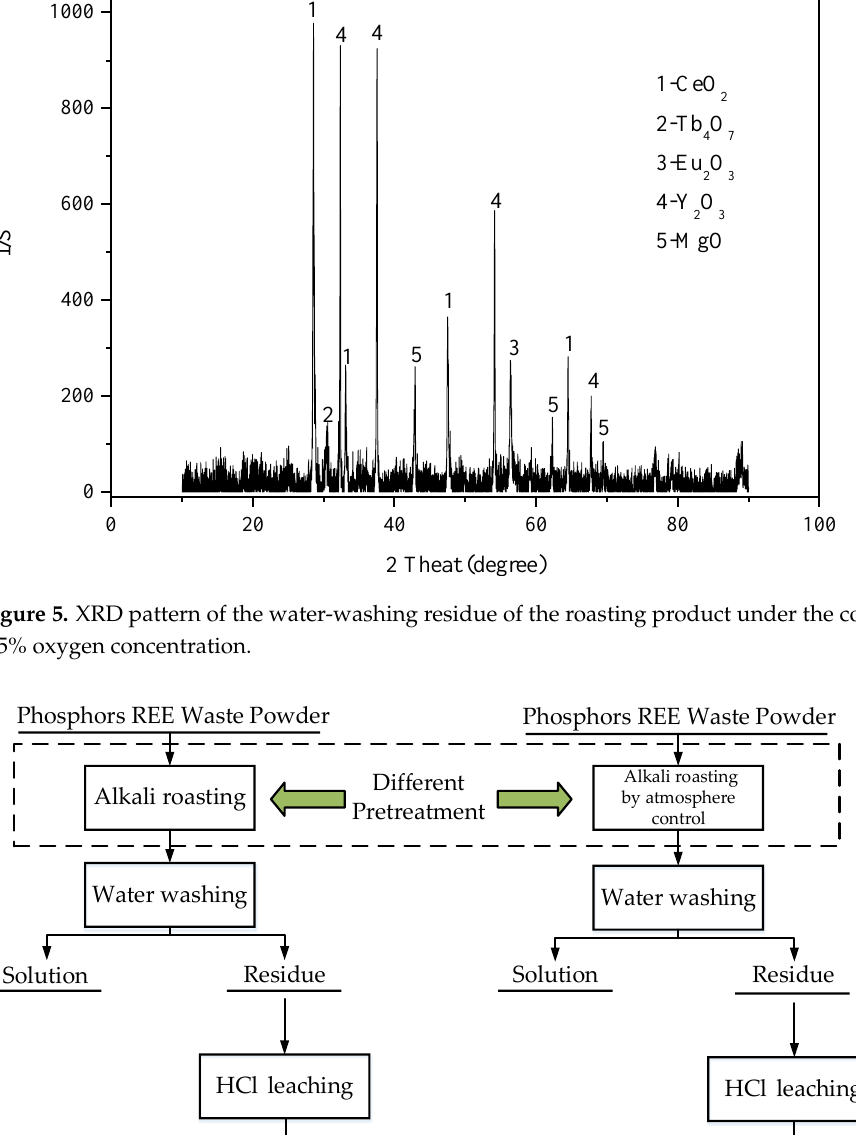
Figure 6. Flowsheet comparison between the commercial process and proposed process.